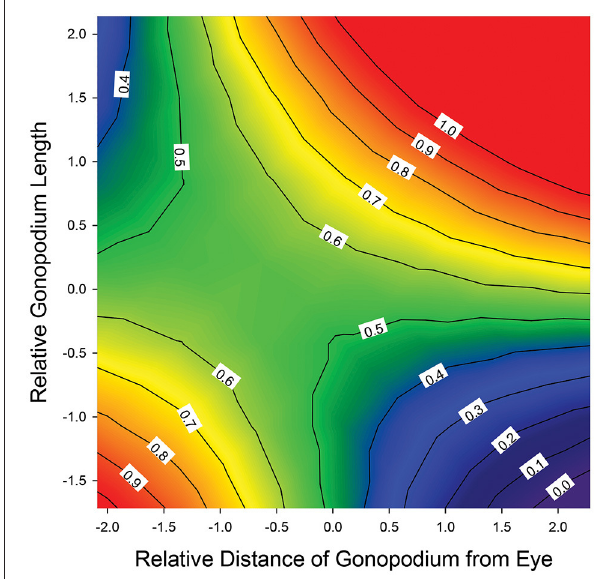
FIGURE 2 | Quadratic selection surface for relative gonopodium length and gonopodial anterior transposition, depicting the predicted mating success of males across the range of trait values. Traits are mean-centered and in units of standard deviation. Genital contact success depicted on the Z axis (elevation), but results are similar for genital contact efficiency (see Supplementary Table 2 ). Surface constructed using all selection gradients (linear, quadratic,